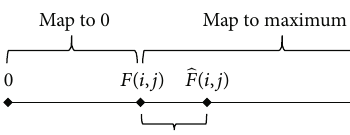
Figure 5: Schematic diagram of binarization